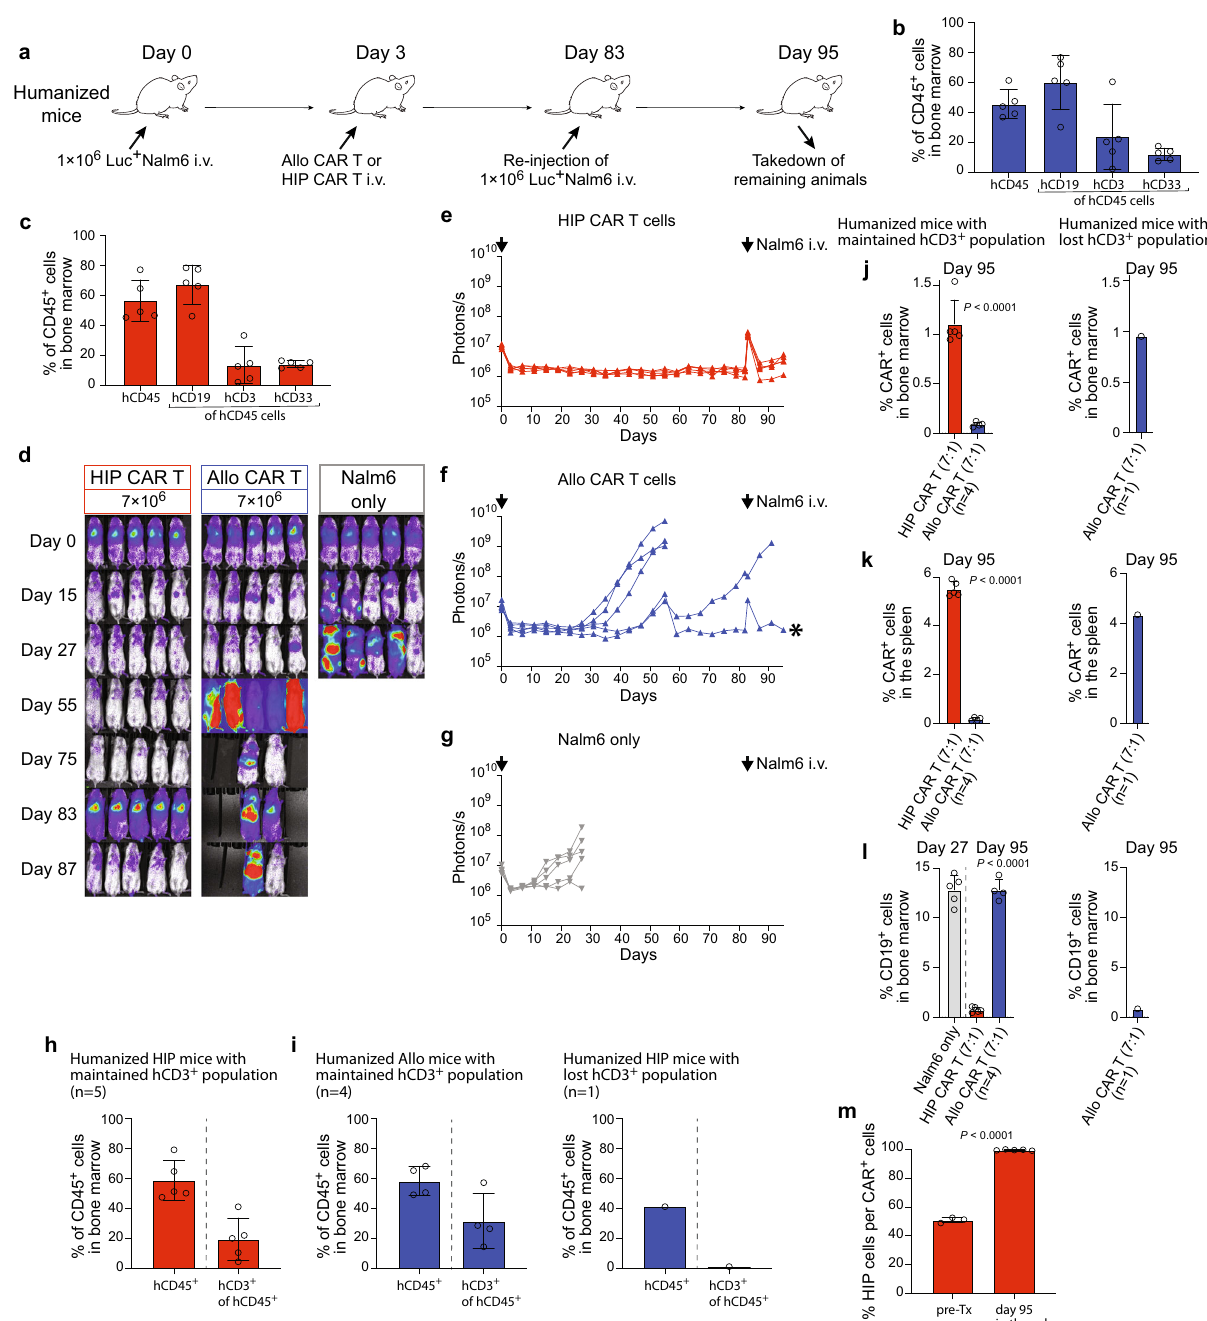
Fig.8|HIPCARTcellsquicklycleartumorcellsre-injectedafter83daysinfully immunocompetent allogeneic humanized mice. a Humanized mice were injec- ted with 1×10 6 Luc + Nalm6 cells and received 7×10 6 allo CAR T cells or HIP CAR T cells on day 3 (one experiment). Then, they received another injection of 1×10 6 Luc + Nalm6 cells on day 83. Spleen and bone marrow were taken after 95 days. b , c Human immune cell reconstitution is shown for all 5 mice in the allo CAR T group( b )andtheHIPCARTgroup( c ).Individualvaluesareshownandmean±SD. * indicates outliers used for further analysis. h , i Reconstitution of human immune cells was assessed in the HIP CAR T ( h ) and the allo CAR T ( i ) groups after eutha- nasia.The percentage ofhCD45 + cells among all CD45 + cellsand the percentage of hCD3 + cells in thehCD45 + population wasquanti fi ed (mean±SD, n =5HIPanimals, n =4 allo animals with maintained hCD3 + population and n =1 allo animal with lost hCD3 + population). j , k The percentages of CAR + cells in the bone marrow ( j ) and